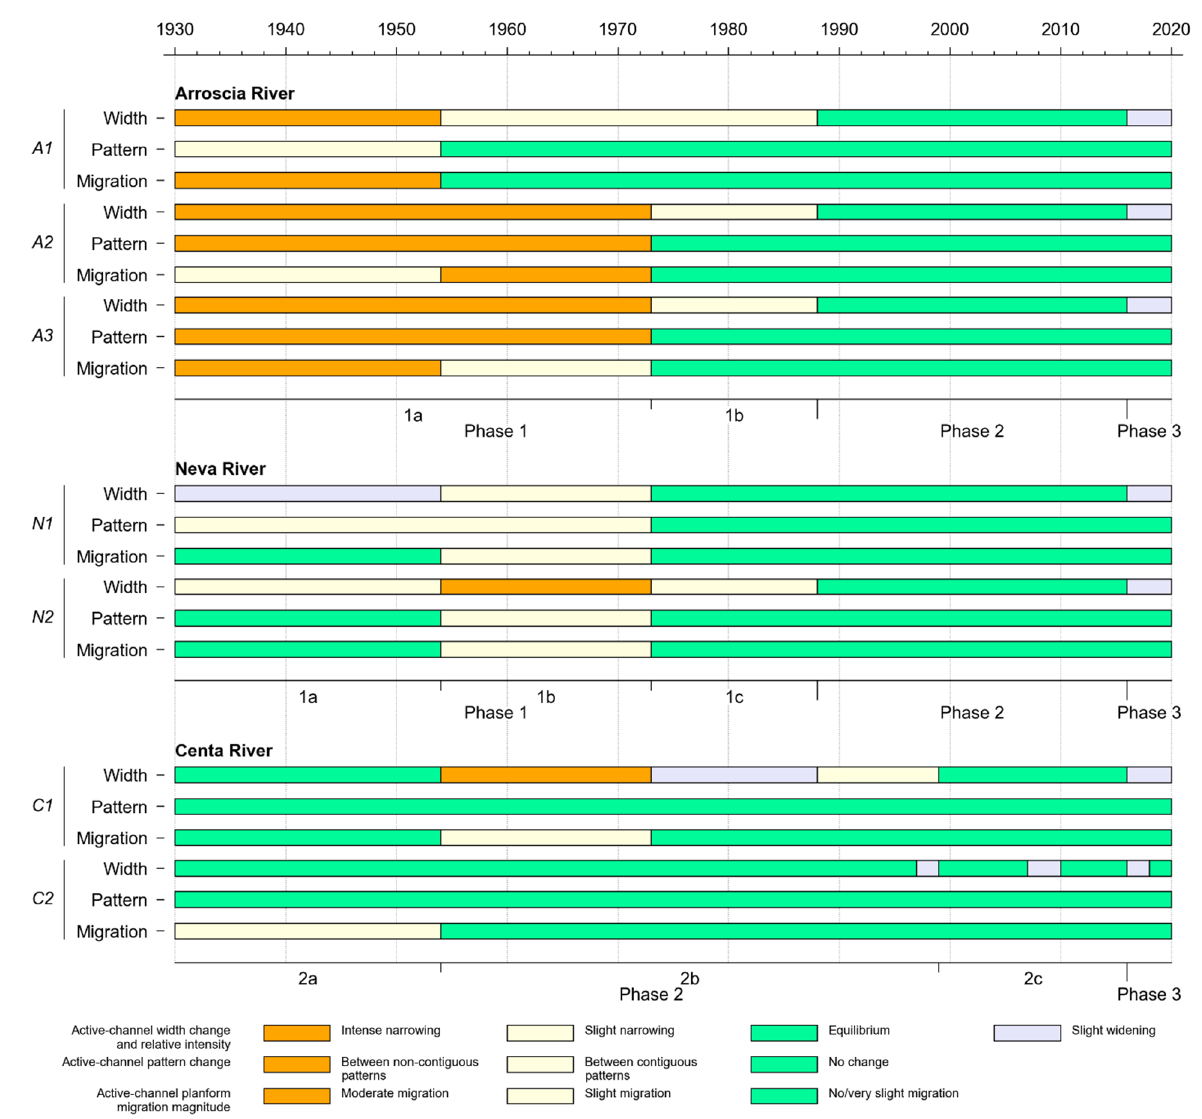
Figure 12. Time chart of reach-scale active channel morphological adjustments and related magnitudes. The terms “contiguous” and “noncontiguous” pattern refer to [52,148]. The active-channel planform migration magnitude was defined according to the combined analysis of CAI and CFI (see Table 2).